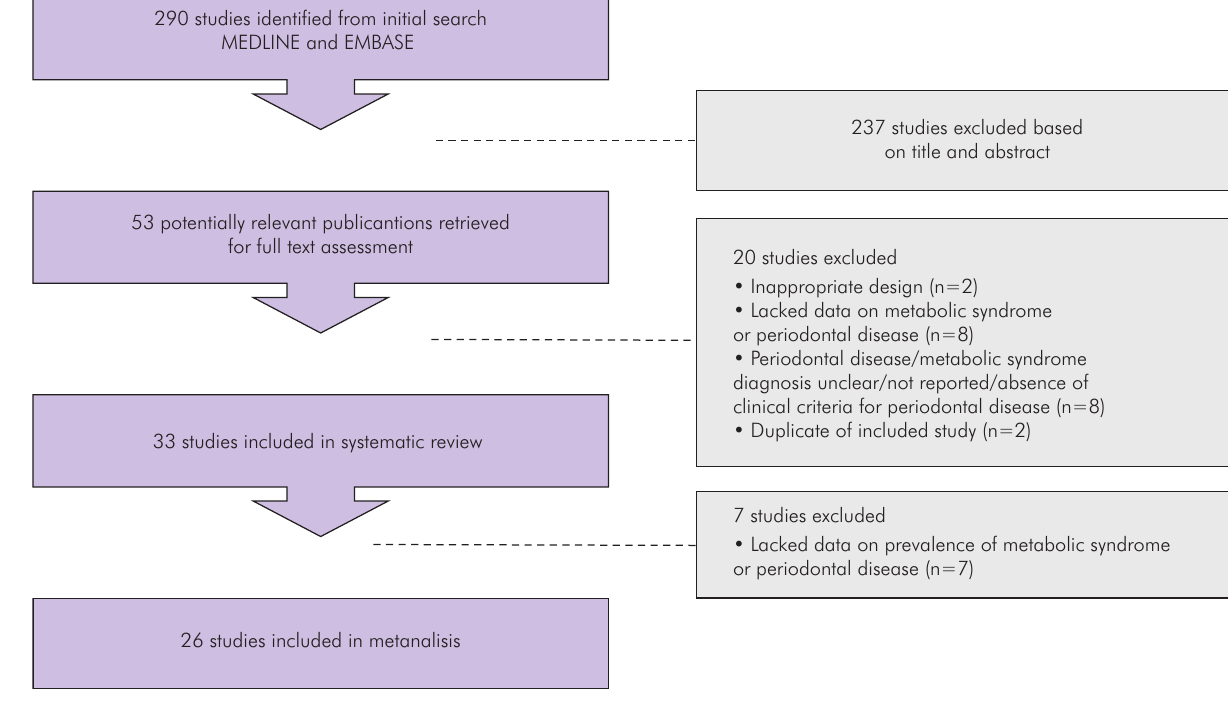
Figure 1. Flowchart of the search for studies, their selection and